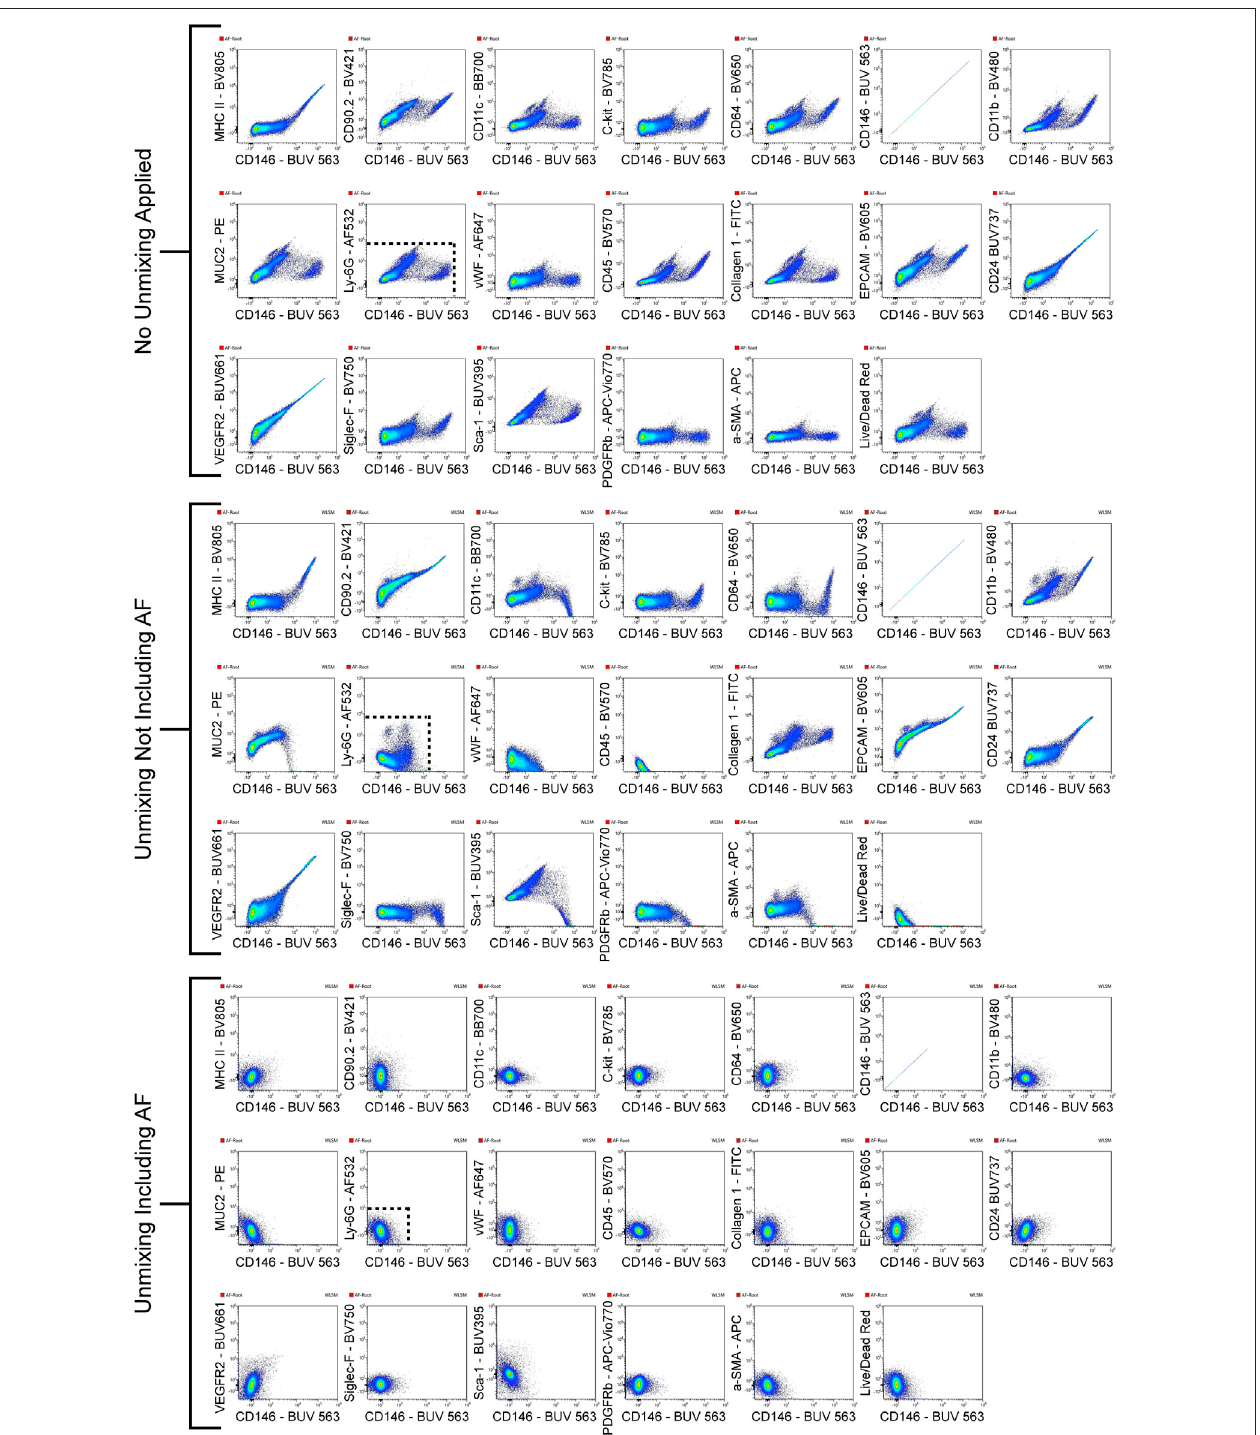
FIGURE2| ImprovedresolutionofunstainedsamplewithAFincludedinunmixing.Theunstained samplewasviewedwithCD146-BUV563onthe x -axisvs.every fl uorescent parameter in the panel on the y -axes. Three sets of these plots are shown: the unstained sample with no unmixing applied, the unstained sample with unmixing applied but no AF populations included in the unmixing, and the unstained sample with unmixing applied and each unique AF population (AF-A, AF-D, AF-E, andAF-F)includedintheunmixing.DottedlinesintheCD146-BUV563vs.Ly-6G – AF532plotshowshowtheresolutionimproveswithunmixingandunmixingwith AF included. From the plots with no unmixing applied to the plots with unmixing applied and AF included, several decades in the dynamic range are preserved.